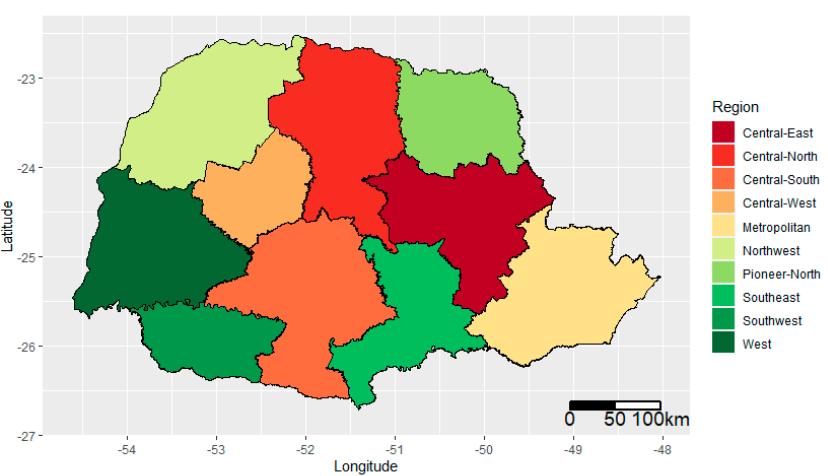
Figure 2. Mesoregions of Paraná state demarcated by the Brazilian Institute of Geography and Statistics (IBGE).